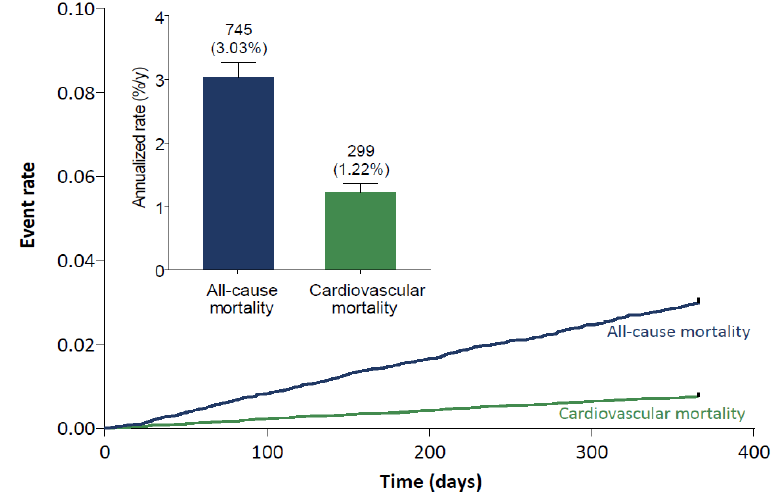
Figure 3. One-year mortality event rates. Numbers above bars represent n (%/y). Error bars represent the upper limit of the 95% confidence interval.